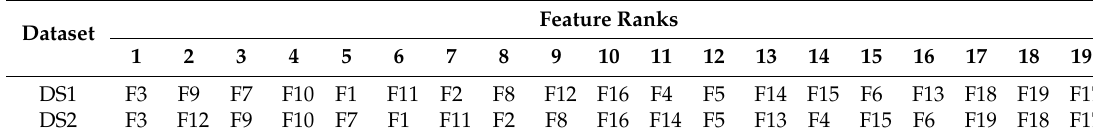
Table 6. The feature rankings obtained from Relief-F on DS1 and Dataset 2 (DS2) for the side of the waist.